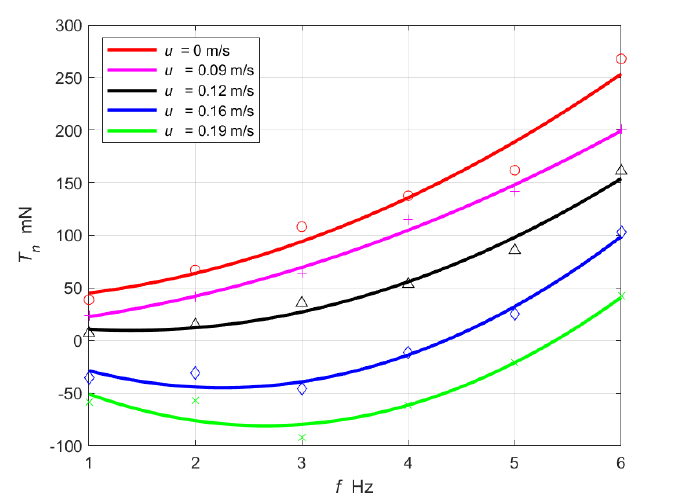
Figure 9. The mean value of the net thrust for an inflexible fin with an additional